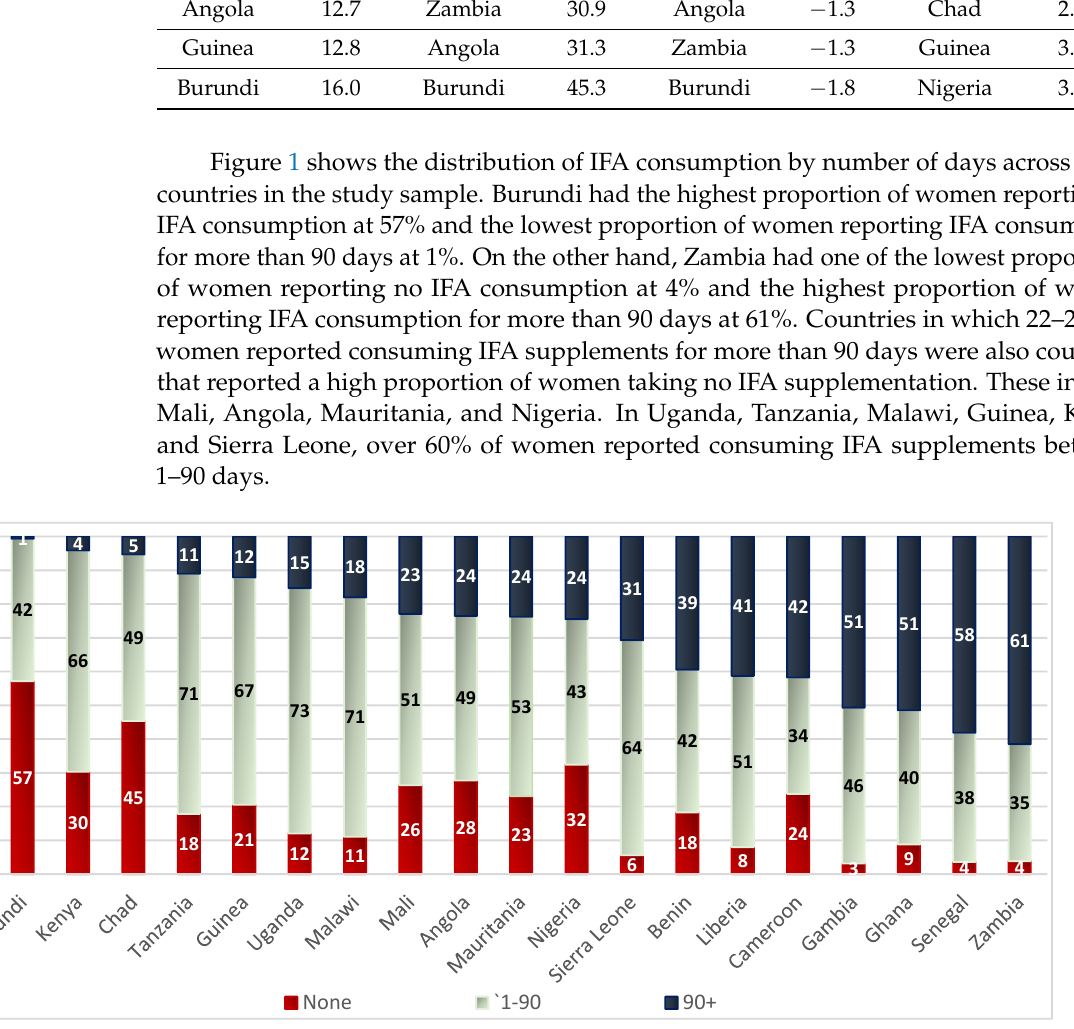
Figure 1. Distribution of IFA consumption (number of days) by country among mothers of youngest child under two years of age.